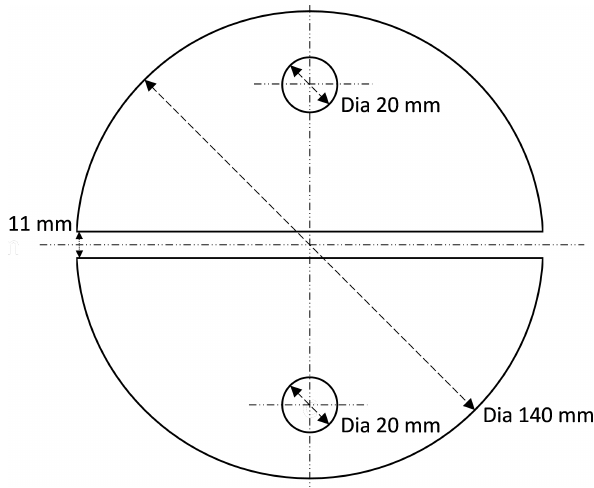
Figure 2: Schematic drawing of the split disks.